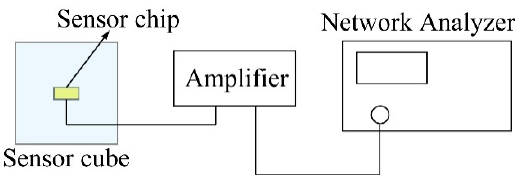
Figure 15. Schematic image of the setup to evaluate the noise level of the sensor.